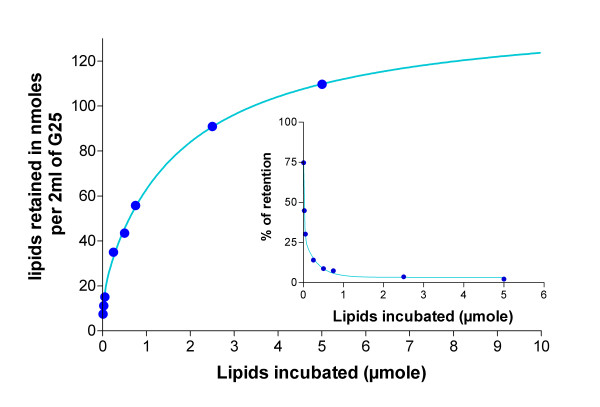
Liposome retention depends on the amount of lipids loaded. Liposomes labeled with Rhod-PE were incubated with 2 mL G25M gel two hours with gentle agitation and poured in columns. Non-retained liposomes collected by washing the column with 40 mL buffer and retained liposomes were eluted by adding 0.5% TX-100.